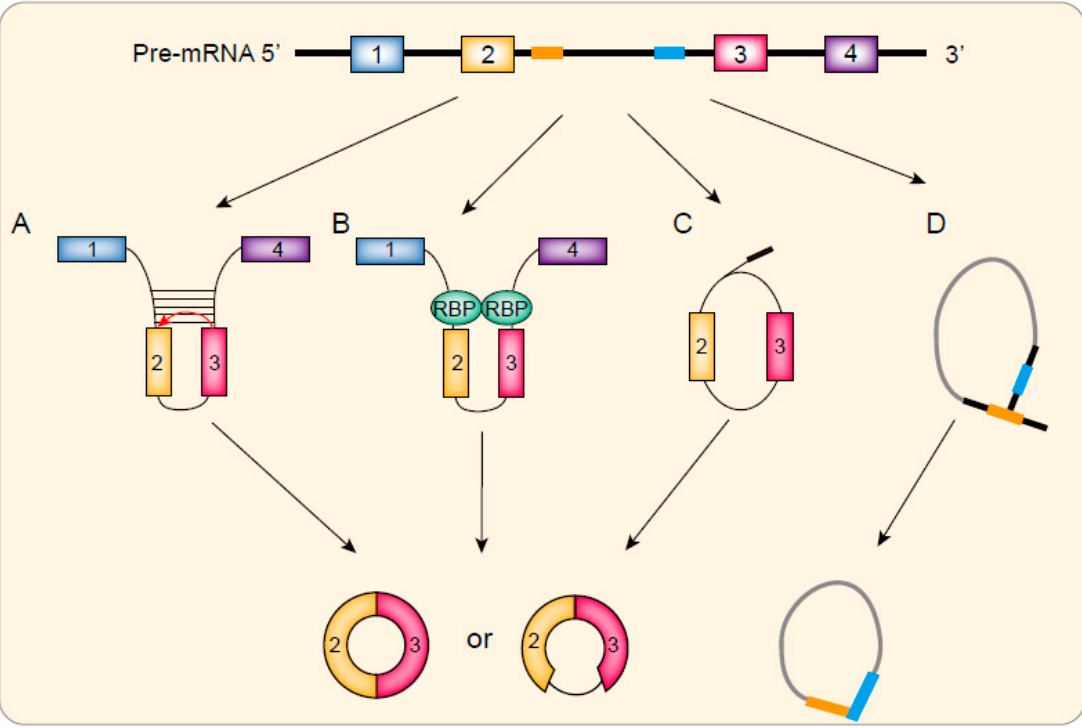
Figure 1. Biogenesis of circRNA. Direct back-splicing model of circRNA formation. ( A ) Reverse complementary sequence or ( B ) RNA binding proteins bring the splicing site together and facilitate back-spcling. EIcircRNA or ecircRNA are produced at last; ( C ) Exon skipping model of circRNA formation. First, the alternative produces a linear RNA and a lariat structure. Then the lariat undergoes internal back splicing and results in the generation of ecircRNA or EIcircRNA; ( D ) Model of ciRNA formation. After canonical splicing, the intron lariat is usually debrached and degraded by exonucleolytic enzyme. However, some intron lariats can escape debraching and cleaved by the exonucleolytic enzyme to form ciRNAs containing 2 ′ - 5 ′ loops.